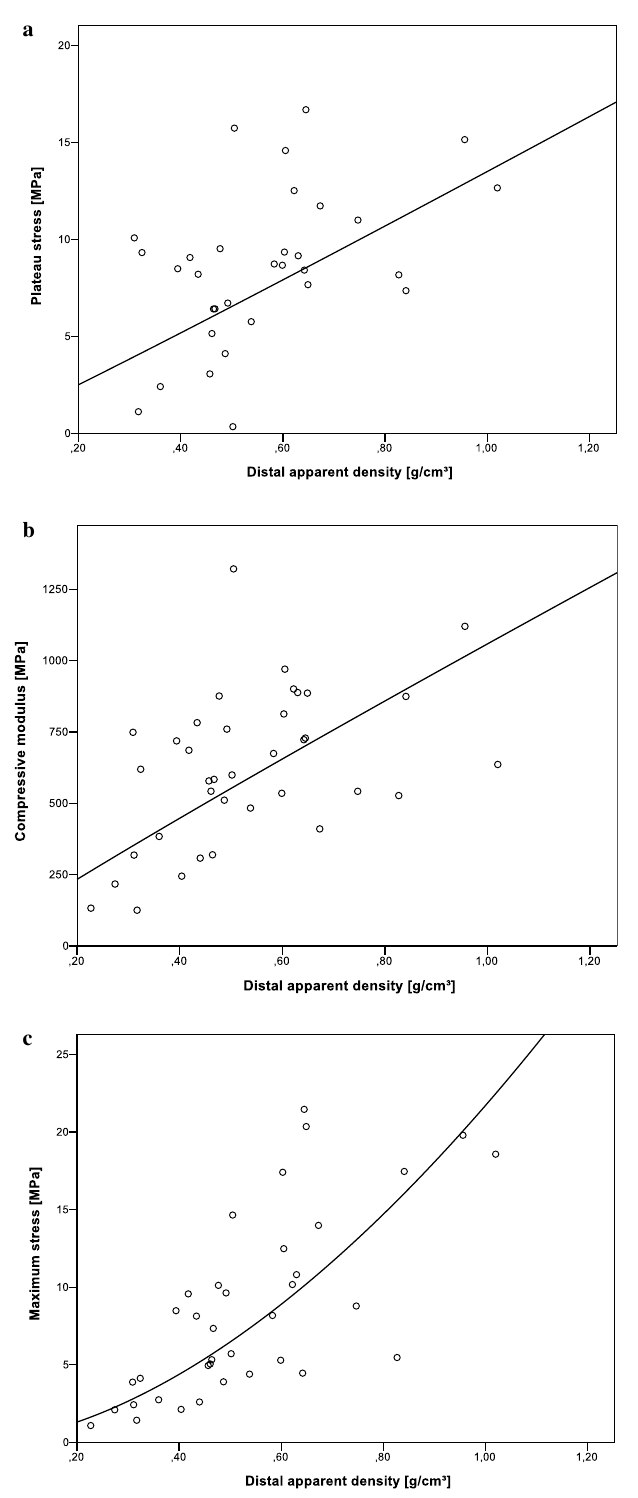
Figure 6. Mechanical properties plotted as power function over the distal apparent density showed best models according to R 2 values (s. Table